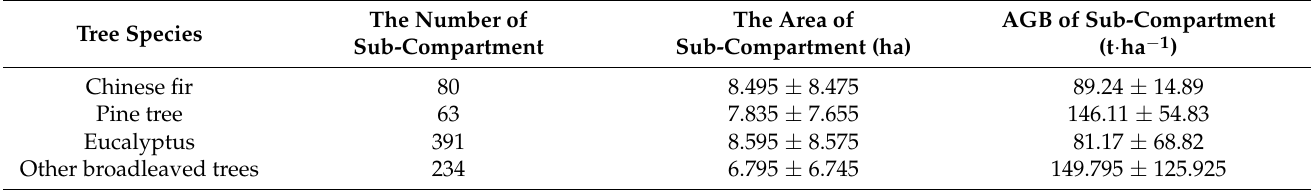
Table 11. Statistics table of forest AGB in the study